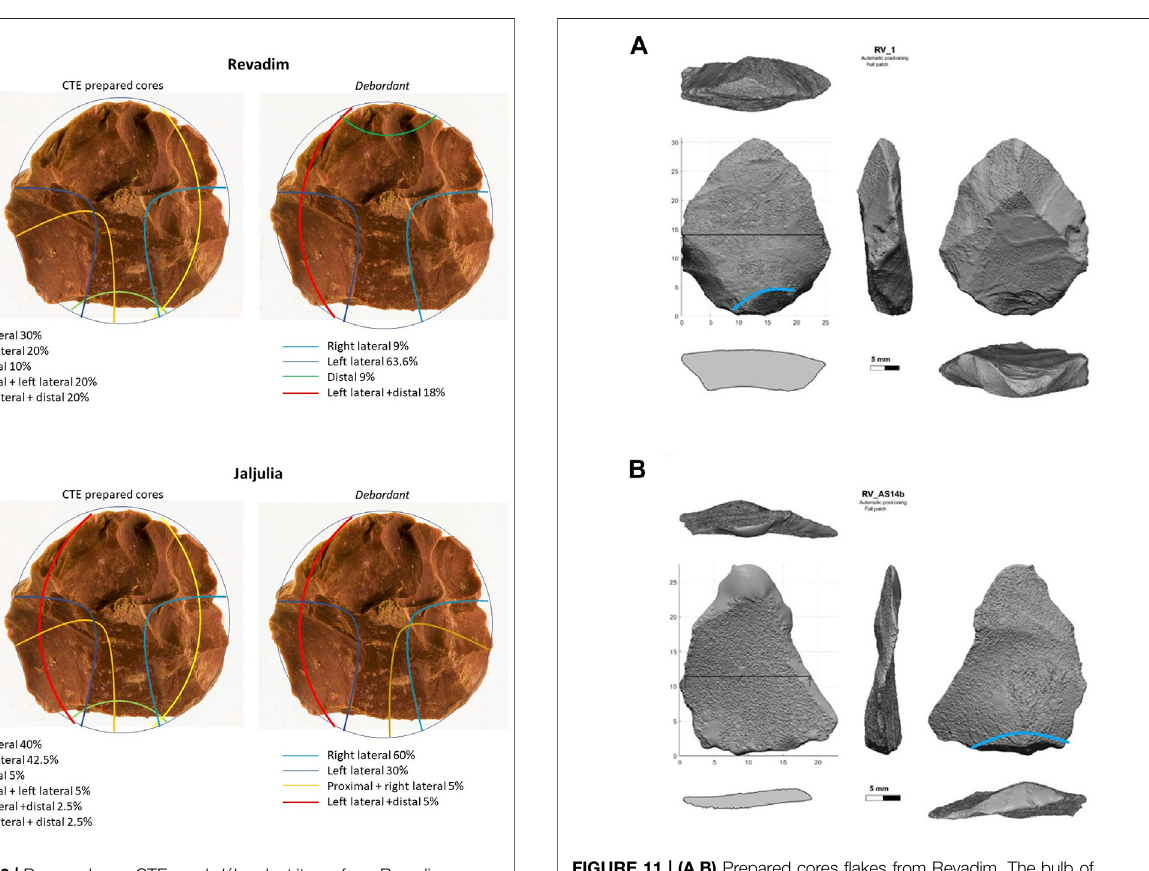
FIGURE 10 | Prepared core CTEs and débordant items from Revadim (A) and Jaljulia (B) , showing the location of removal in relation to the core circumference. Note that the core is shown for illustrative purposes only.